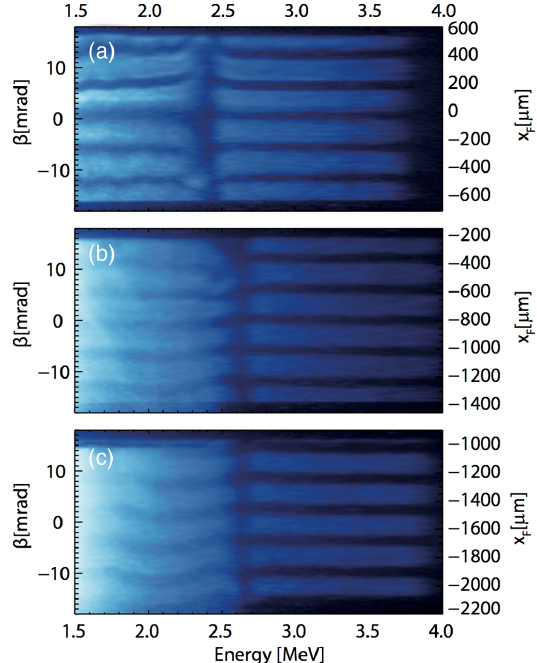
FIG. 5. Successive shots while probing in longitudinal geom- etry and varying the x F parameter. The probe timing ( t corresponds to the proton t-pump energies ϵ 2 . 6 MeV [(b) and (c)], and ϵ pump ¼